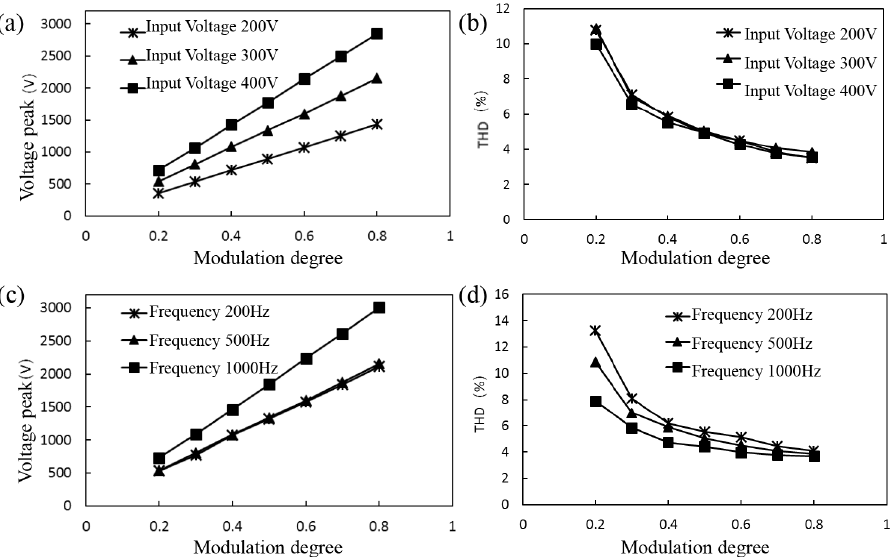
Figure 6. The peak of sinusoidal output voltage and total harmonic distortion (THD) vary with modulation degree. (a), (b) Frequency 500 Hz, load 50 MΩ; (c), (d) Input voltage 300 V, load 50